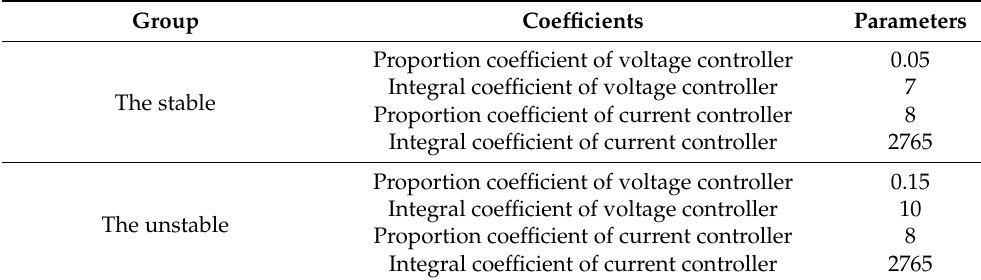
Table 2. Parameters of the dual-loop voltage control scheme.